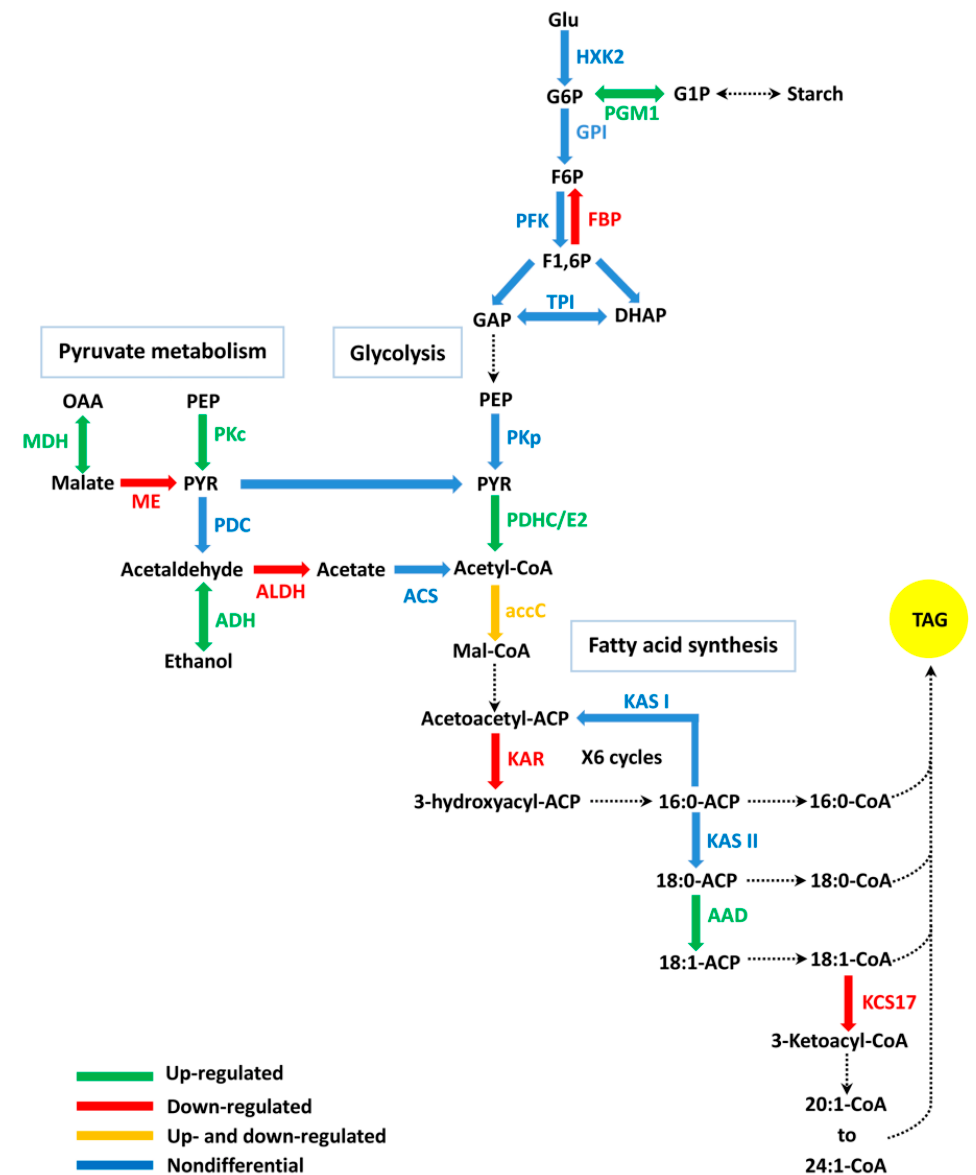
Figure 5. Summary of the DEGs in pathways that are involved directly or indirectly in oil biosynthesis in high-oil yellow horn. Green represents up-regulated genes, red represents down-regulated genes, orange represents both up-regulated and down-regulated genes and blue represents non-differentially expressed genes. Dashed lines indicate multistep pathways. Abbreviations: AAD, acyl-ACP